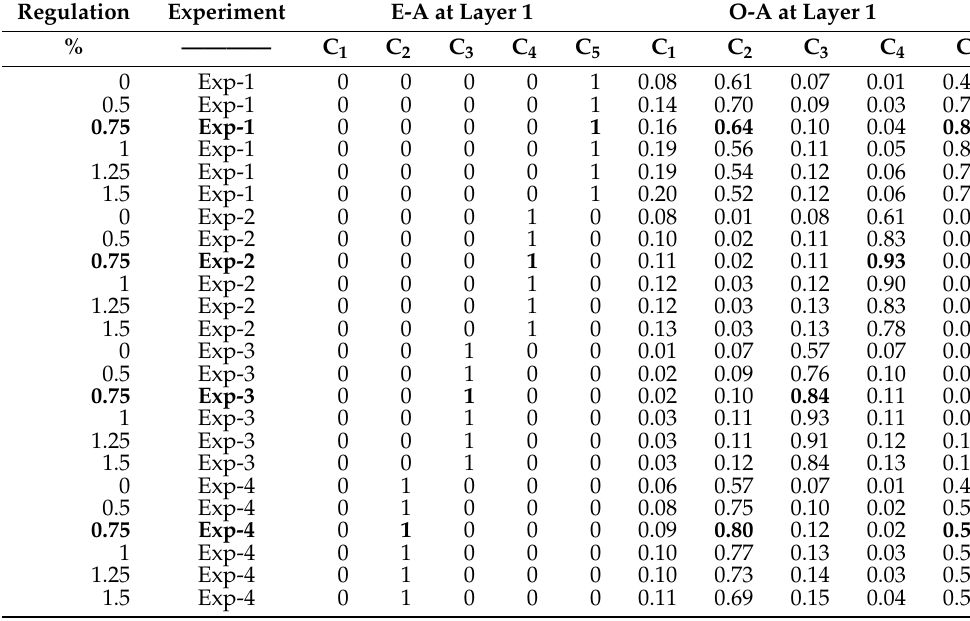
Figure 8. The trajectories of activation observed at input layer 0 while carrying out one thousand iterations of the geometric back-propagation (GBP) algorithm. The red circle is the starting point of trajectory, and the black circle is the activation value after the thousandth iteration. The graphs also depict the trajectories observed at input layer 0 with six regulation factors ρ (0%, 0.5%, 0.75%, 1%, 1.25%, and 1.5%). Each graph visualizes the recalled activation for five single-cue recall (SCR) experiments. Table 1. Observations of activations at abstract concept layer 1 for SCR